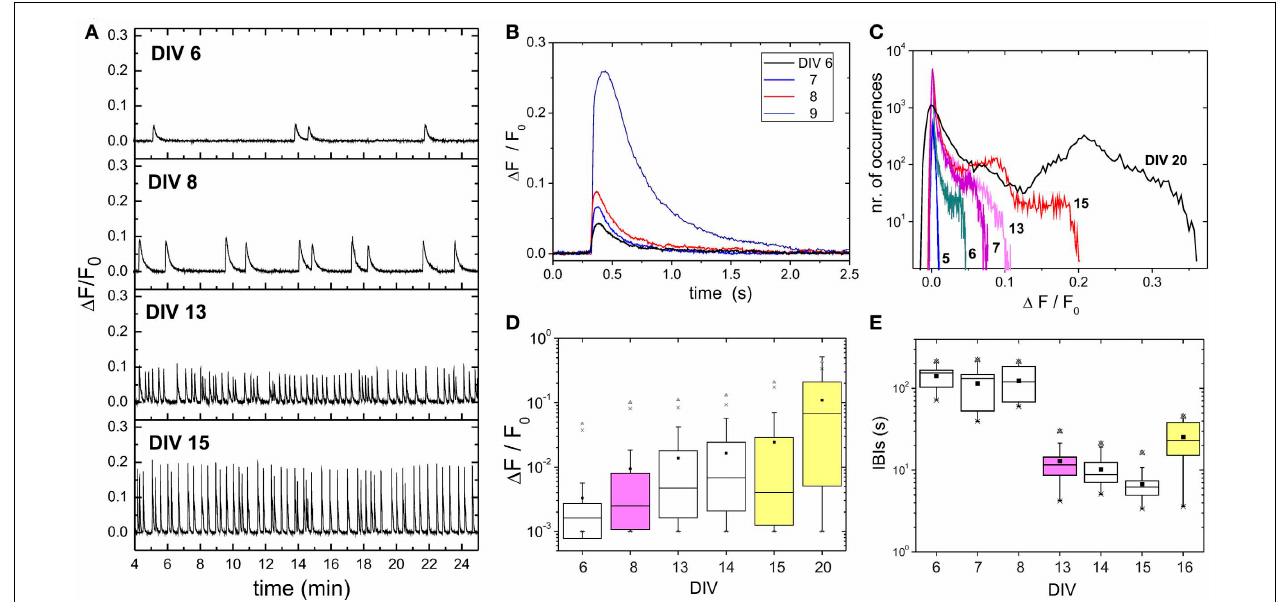
FIGURE 2 | Network development. (A) Examples of fluorescence traces of spontaneous activity along 15 days of development. All measurements correspond to cultures from the same batch. Traces are the average over the monitored network population ( (cid:4) 2000 neurons). The peaks of fluorescence signal identify bursting episodes. The time elapsed between two consecutive bursts define the interburst interval (IBI). The measurement at day in vitro (DIV) 6 corresponds to the first observation of spontaneous bursting activity in the batch. (B) Detail of a bursting event (averaged over the monitored network population) during the early stages of development to illustrate the substantial increase in fluorescence amplitude after DIV 8. (C) Histogram of the network-averaged fluorescence signal for representative stages of